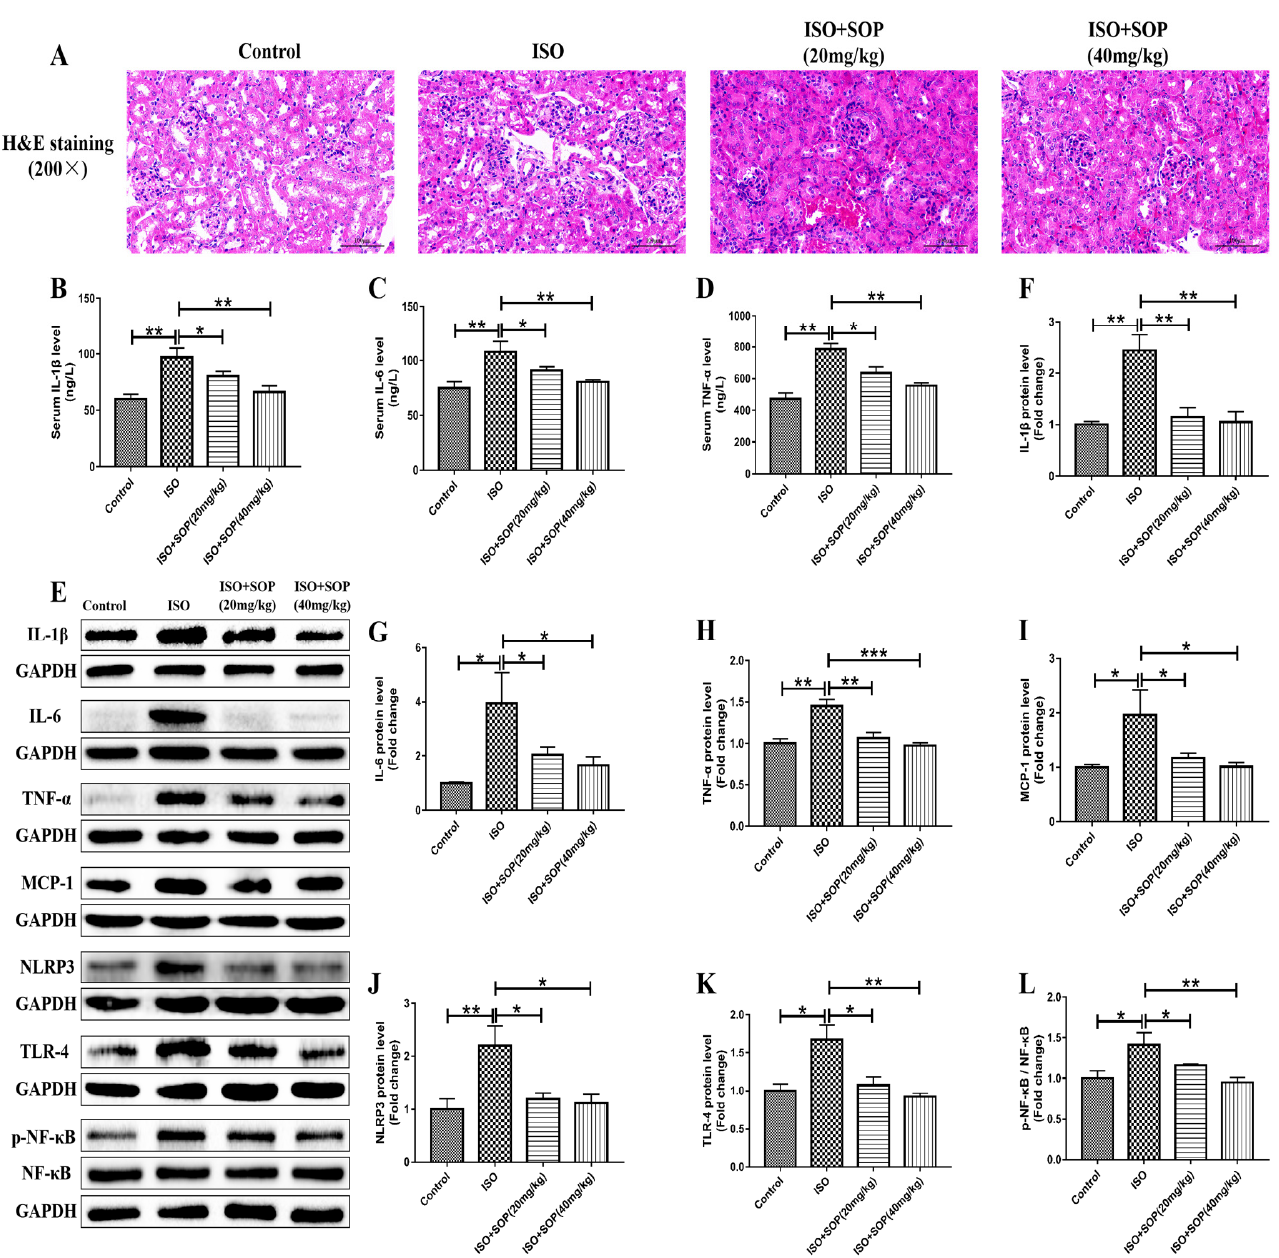
Figure 2. ( A ) An H&E staining assay in kidney tissues was conducted to evaluate pathological changes (n = 7–8). ( B – D ) ELISA kits were used to measure serum inflammatory cytokines such as IL-1 β , IL-6 and TNF- α (n = 7–8). ( E – J ) The protein expression levels of inflammatory cytokines such as IL-1 β , IL-6, TNF- α , MCP-1 and NLRP3 were investigated using a Western blotting assay (n = 7–8). ( E , K , L ) The protein expression levels of TLR-4 and p-NF- κ B were also detected using a Western blotting assay (n = 7–8). * p < 0.05, ** p < 0.01 and *** p < 0.001. Data represent the mean ± SD of at least three separate